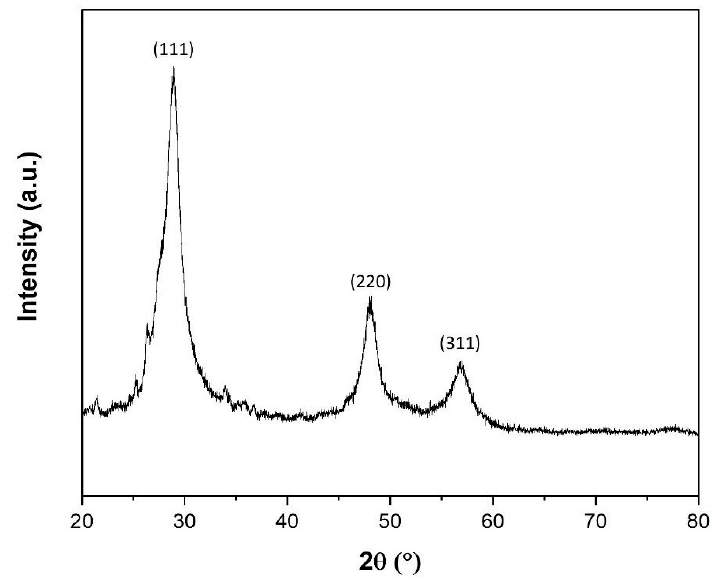
Figure 4. XRD pattern of ZnS nanostructures.